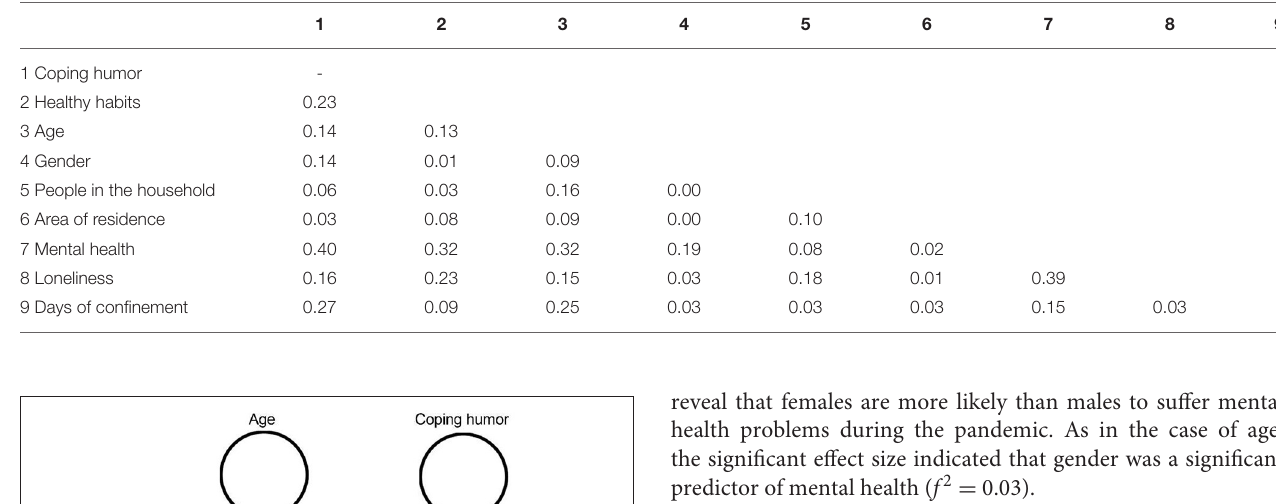
TABLE 4 | HTMT ratios for the measurement model.